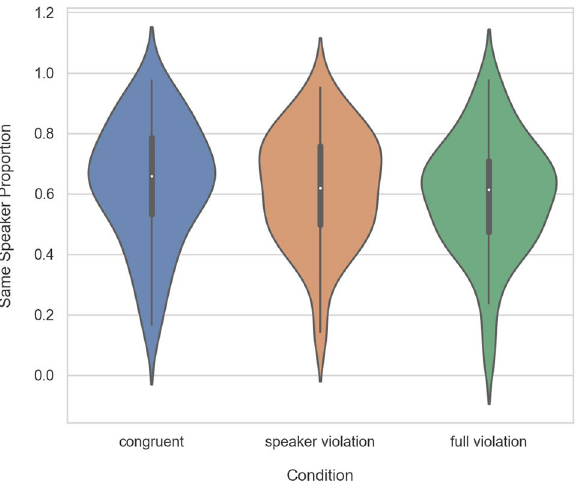
Figure 2. Violin plot showing the proportion of stimuli perceived as spoken by the same speaker in the congruent , speaker violation and full violation conditions in Experiment 2. The white dot indicates the median, the thick gray line represents the interquartile range, and the thin gray line represents the rest of the distribution barring outliers. The overall shape indicates the kernel density estimation of the underlying